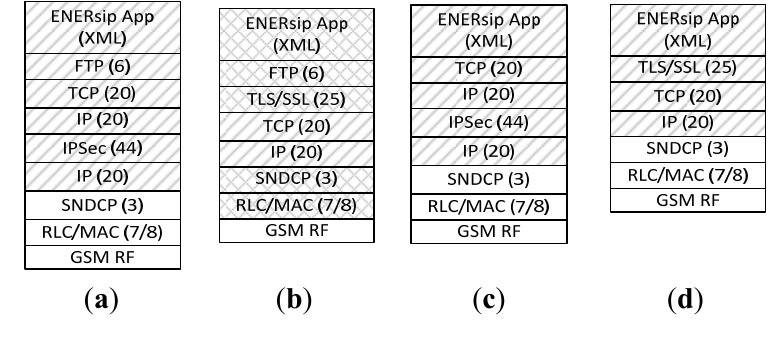
Figure 11. Protocol stack at CNTR and M2M GW for: ( a ) IPSec & Aggr; ( b ) TLS/SSL & Aggr; ( c ) IPSec & FF; ( d ) TLS/SSL &